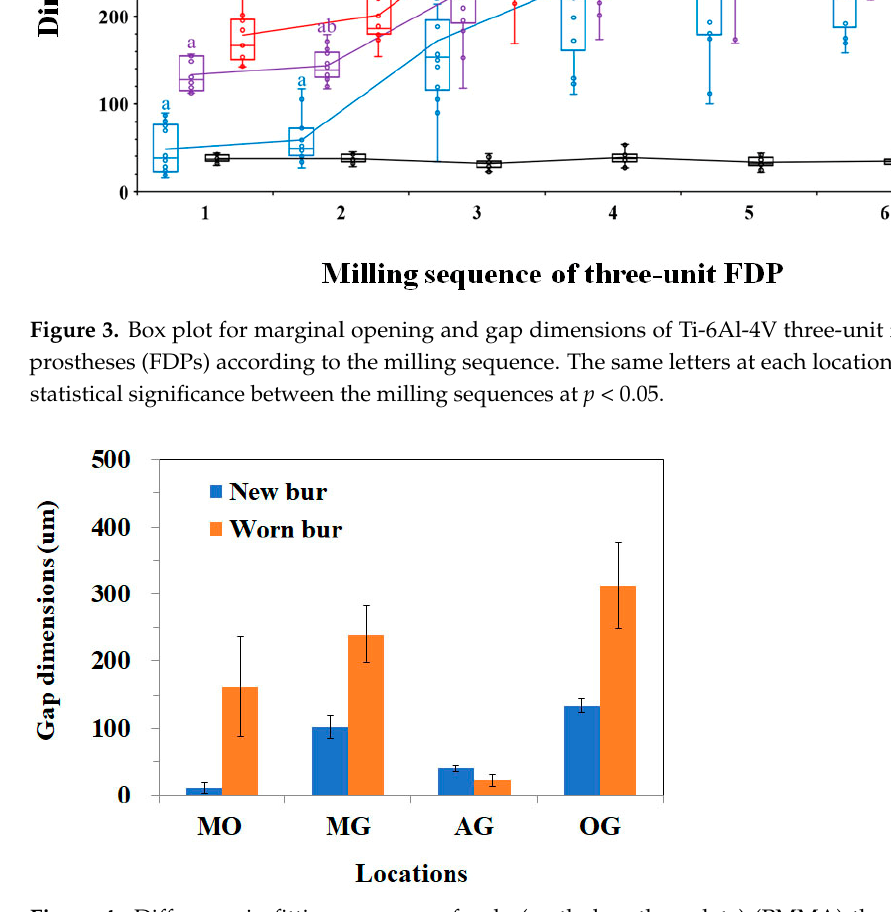
Figure 4. Difference in fitting accuracy of poly (methyl methacrylate) (PMMA) three-unit fixed dental prostheses (FDP) milled by as-received new bur and the worn burs used for milling of six titanium FDPs.